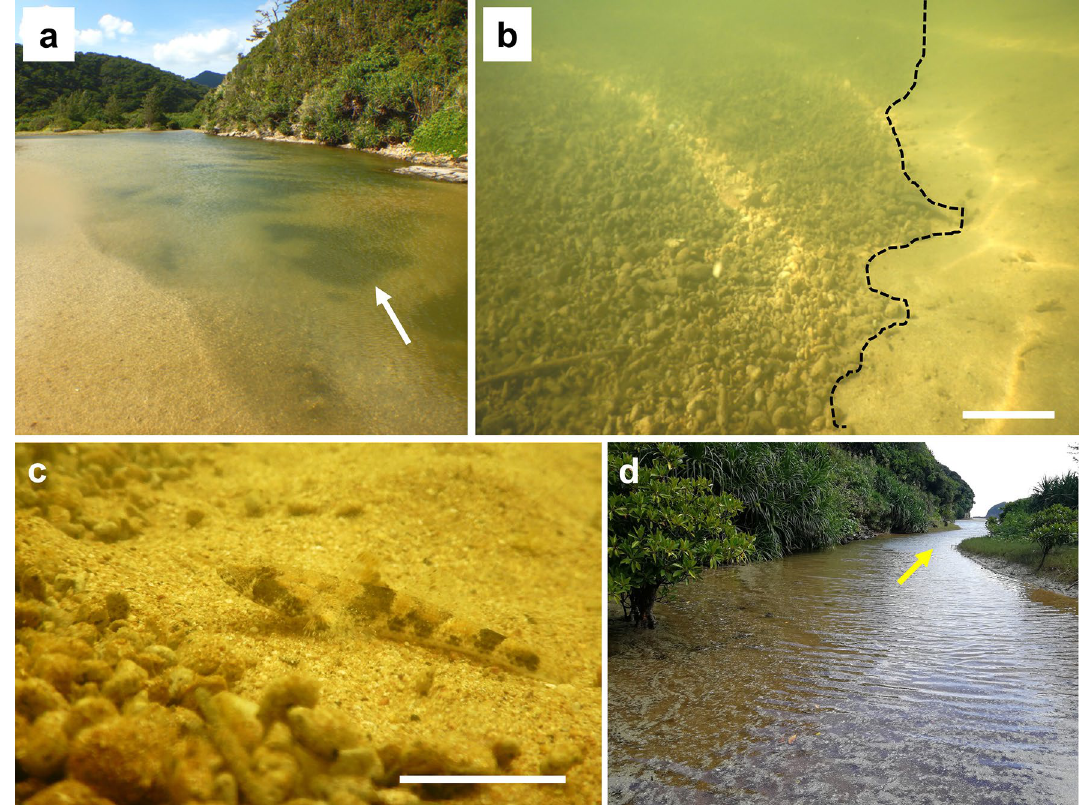
Figure 8. Pumice has begun to settle onto the bed of the brackish river. ( a ) In the lower reaches of the Ibu River (26°75 ′ 71.47 ″ N, 128°31 ′ 97.47" E), connecting to the coast north of the Ibu beach. Photo taken from the estuary side at low tide. The white arrow points to a dark gray aggregation of pumice on the bottom of the river. ( b ) Enlarged image of (a). The black dotted line marks the boundary between the pumice stones (left) and the original sandy river bottom (right). Supplementary Video 5, showing pumice stones swaying in the water, was recorded in this area. Scale bar: 10 cm. ( c ) Psammogobius biocellatus can be seen at the river bottom. Pumice stones were located left on this image. ( d ) A little further up the river, where mangroves can be seen to the left. Yellow arrow points toward the estuary. These photos were taken on 13 November 2021. At the same location, filamentous algae were growing rapidly on the pumice surface in mid-January (see Supplementary Fig.